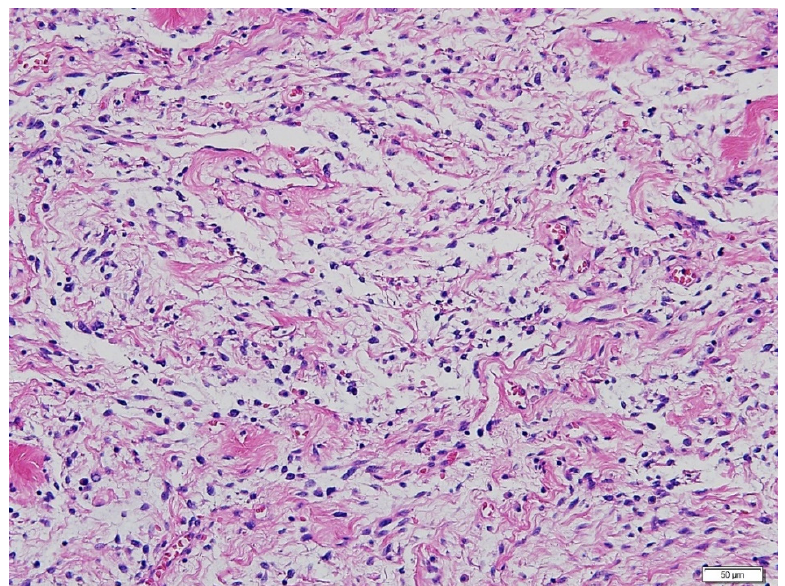
Figure 3. Hematoxylin-eosin staining of the lung mass. Microscopic examination revealed metastatic lung nodules with small, uniform, and bland tumor cells with spindled nuclei and scant cytoplasm, in the background of rich small arterioles or capillary networks. (Magnification 200×).